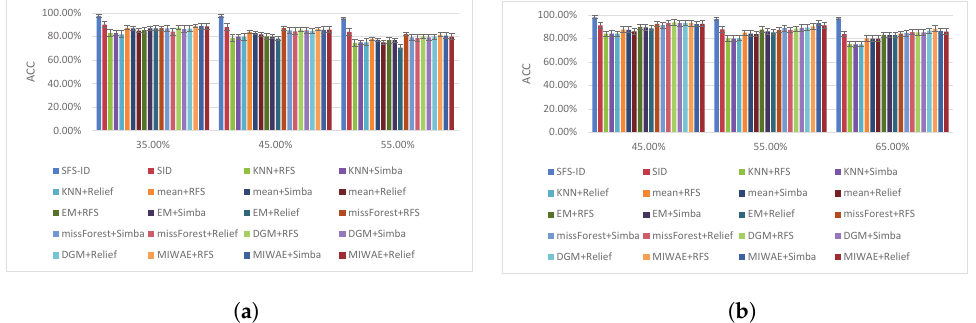
Figure 5. Accuracy under different missing ratios for DLBCL and Mnist datasets. ( a ) DLBCL. ( b ) Mnist.